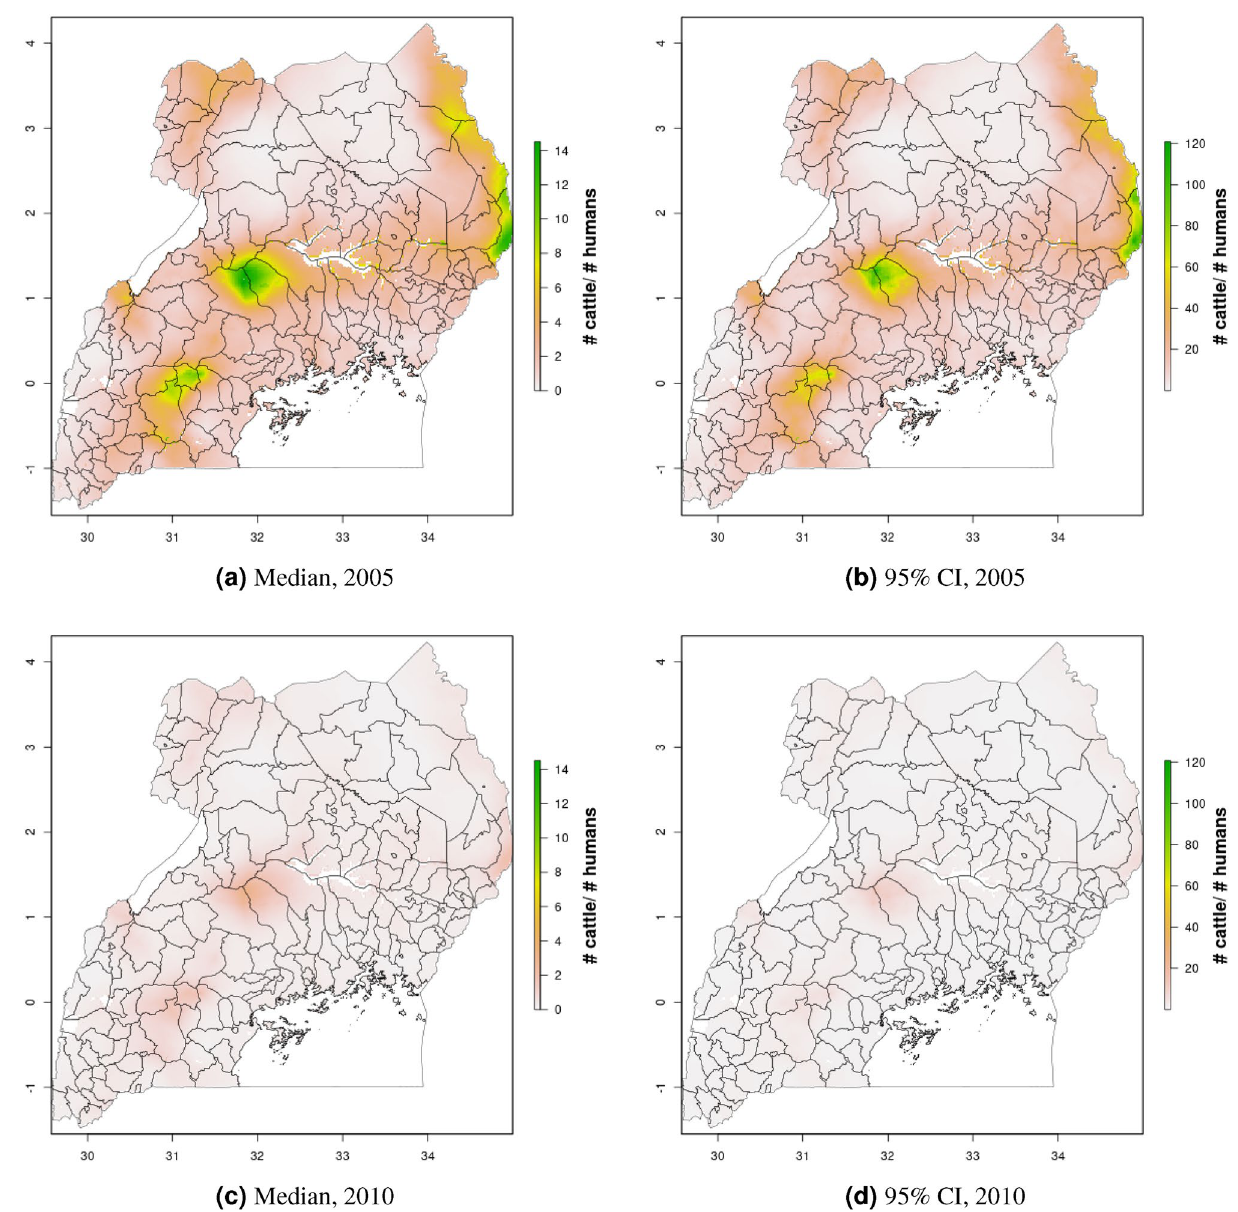
Figure 6. Cattle density mapping results, Uganda, 2005 and 2010. Median ( a, c ) and width of posterior 95% credible interval ( b, d